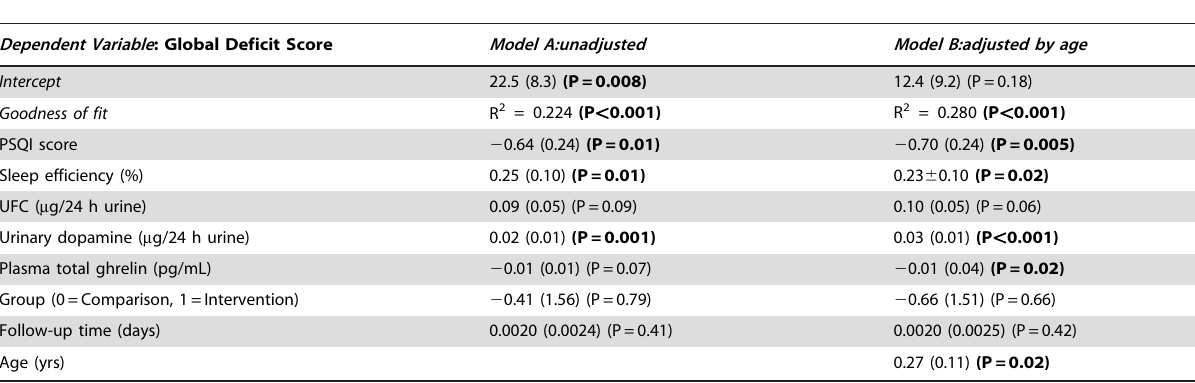
Table 4. Mixed models for Global Deficit